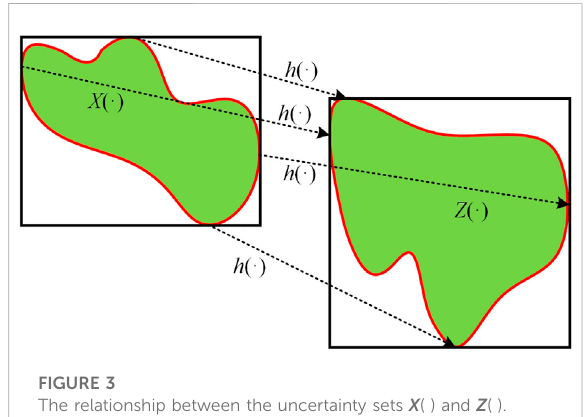
each layer of neural network in LUBE can be adjusted according to actual situation.